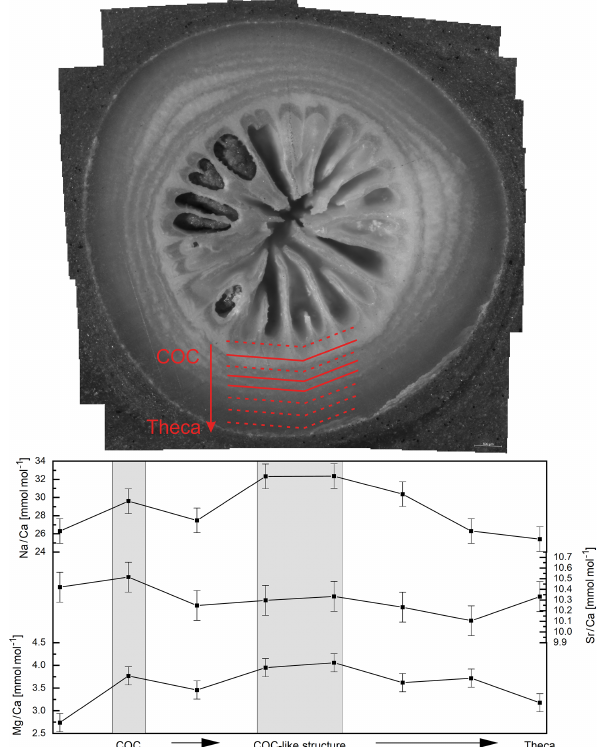
Figure 2. Intraindividual element heterogeneities of one sample from Lopphavet ( D. pertusum ). Shaded gray areas indicate COC and COC-like structures (solid lines in sample picture). Error bars indicate 2SD of the JCp-1 mean. Within the uncertainty Sr / Ca ratios show no significant changes throughout the coral, whereas Mg / Ca and Na / Ca show variations of 1.25 and 6mmolmol − 1 , re-